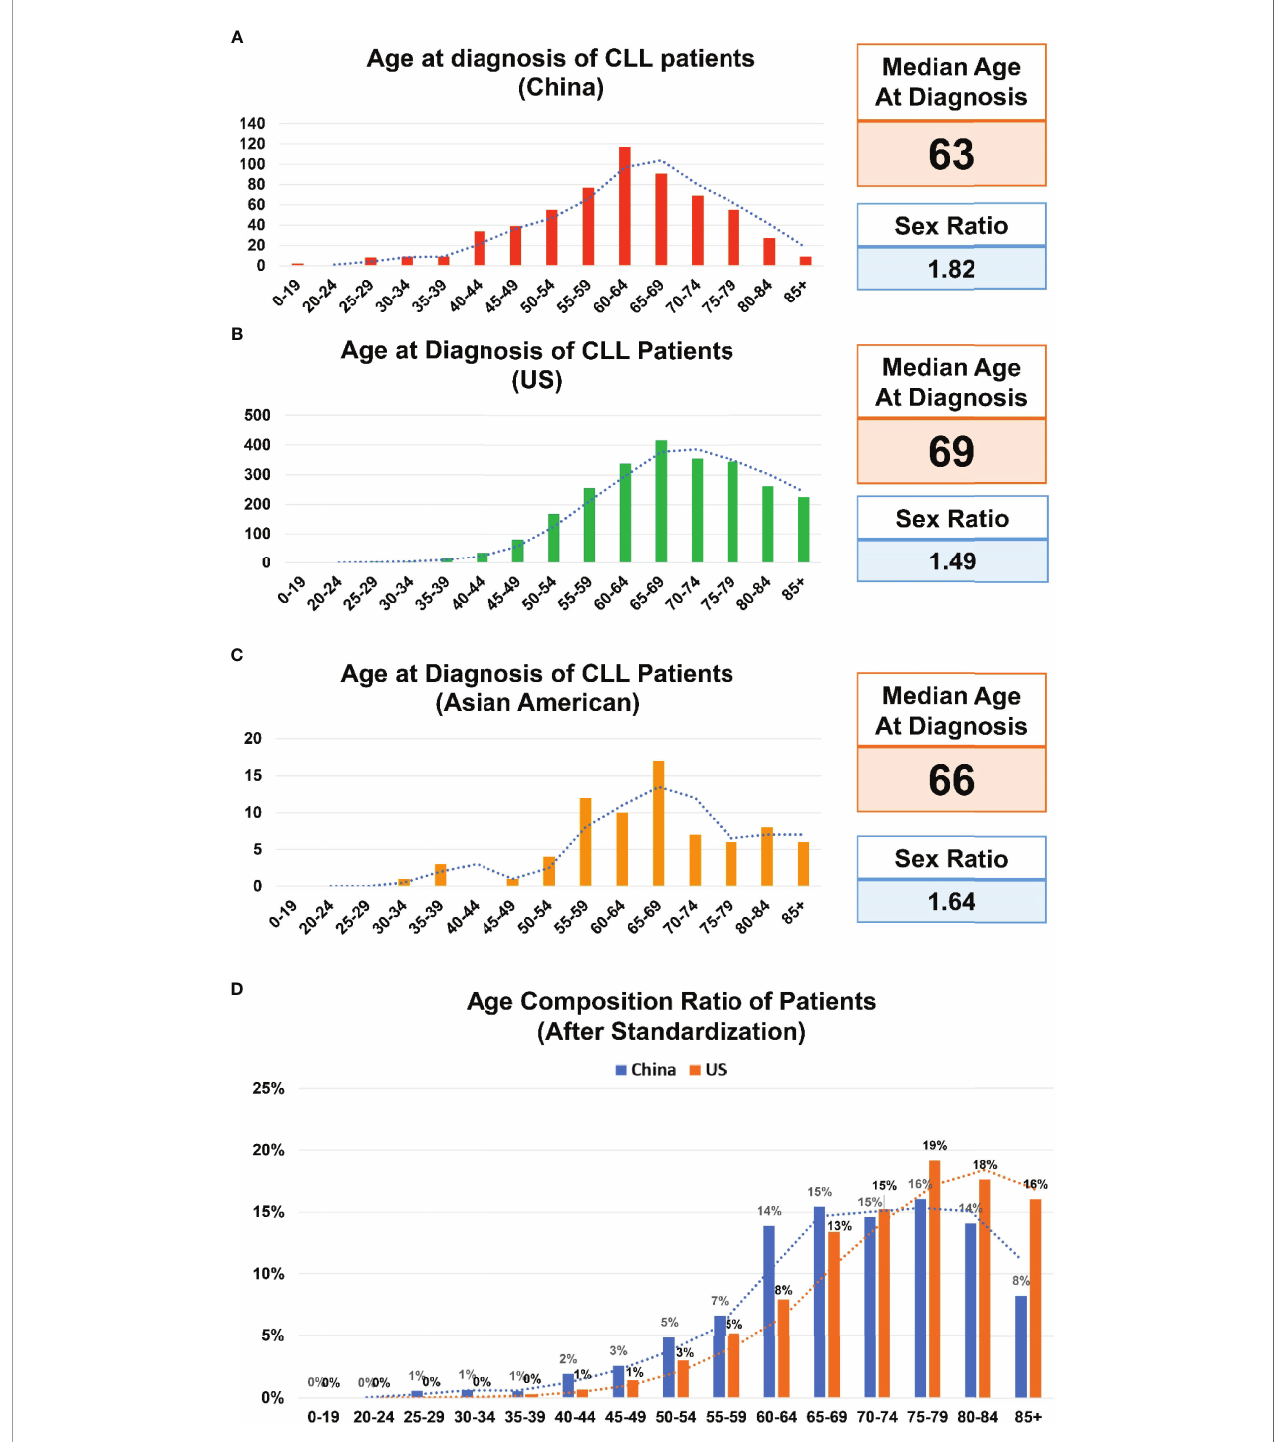
FIGURE 1 | Age composition of CLL patients. (A) Age composition of Chinese patients with chronic lymphocytic leukemia (CLL) included in the Shandong Provincial Hospital CLL (SPHCLL) database from 2010 to 2021. (B) Age composition of CLL patients of predominately European descent registered in the Surveillance, Epidemiology, and End Results (SEER) database from 2010 to 2018. (C) Age composition of Asian Americans with CLL registered in the SEER database from 2010 to 2018. (D) Age composition ratio of CLL patients after standardization according to the age distributions of the United States (US) and